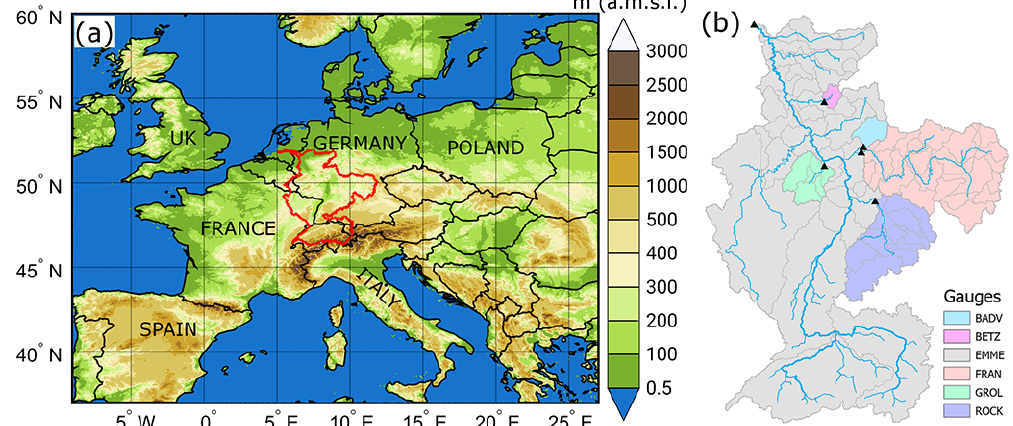
Figure 1. Maps of the Rhine basin with (a) the elevation (in meters above mean sea level; basin marked with red contour) and (b) overview of the location (triangles) and associated catchments (colored shading) of gauging stations that were chosen for model